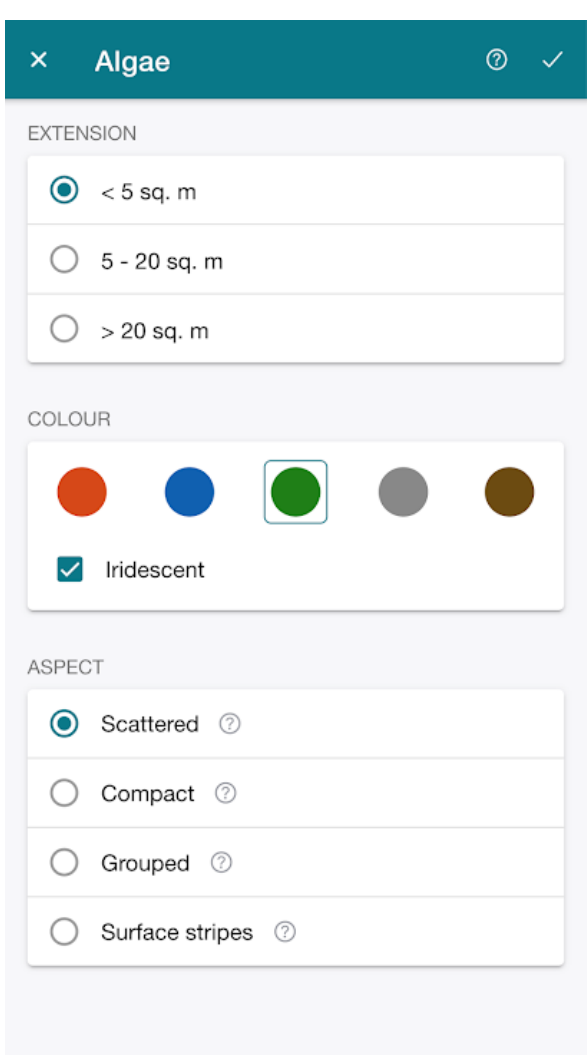
Figure 7: Example of parameters related to the observation of algae in SIMILE Lake monitoring